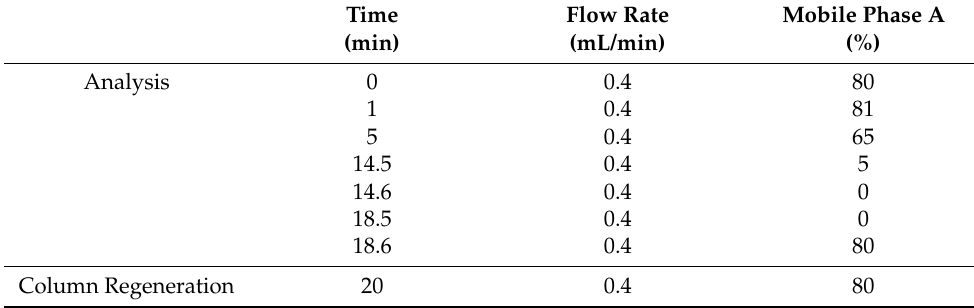
Table 8. LC-gradient conditions center